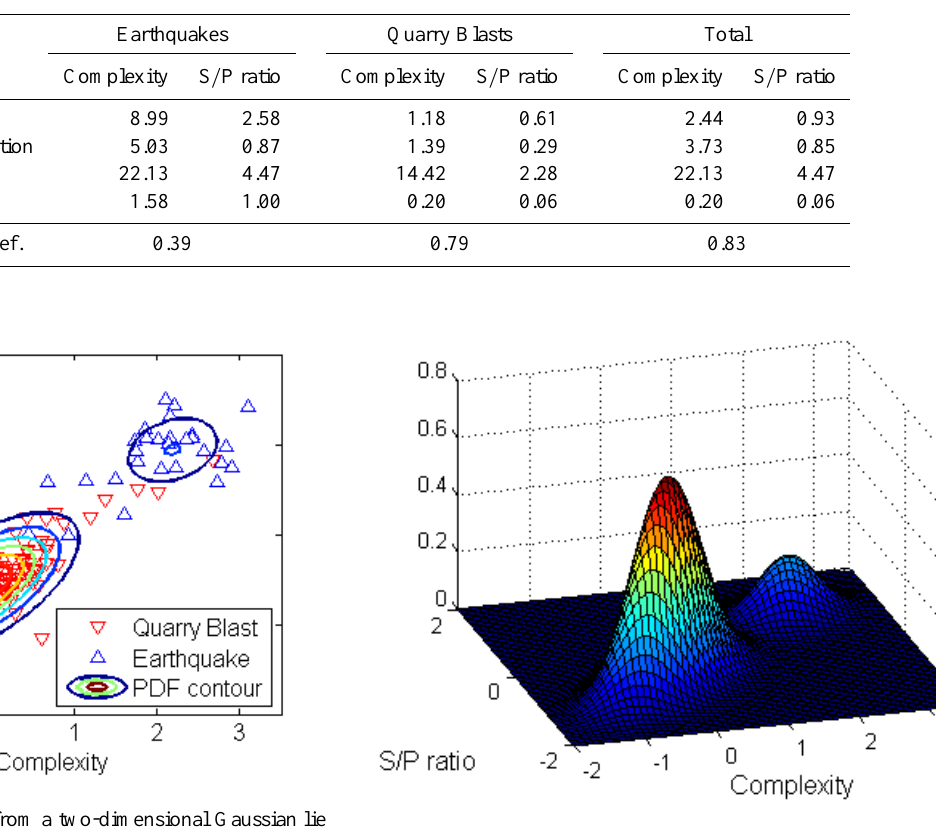
Fig. 4 Contours of probability density function (PDF) of the Gaussian mixture model. Fig. 4. Contours of probability density function (PDF) of the Gaus- sian mixture